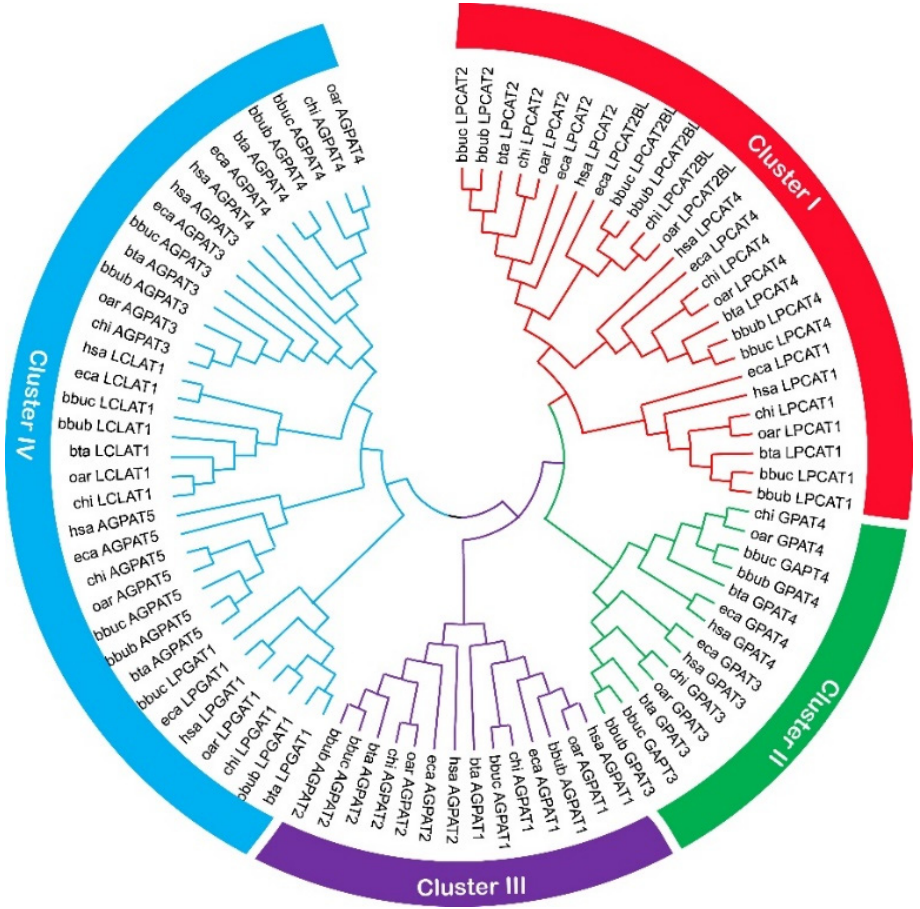
Figure 1. Phylogenetic relationship of AGPAT proteins in seven representative mammals. Line or circle with different colors indicates different clusters. River buffalo: bbub; swamp buffalo: bbuc; cattle: bta; goat: chi; sheep: oar; horse: eca; human: